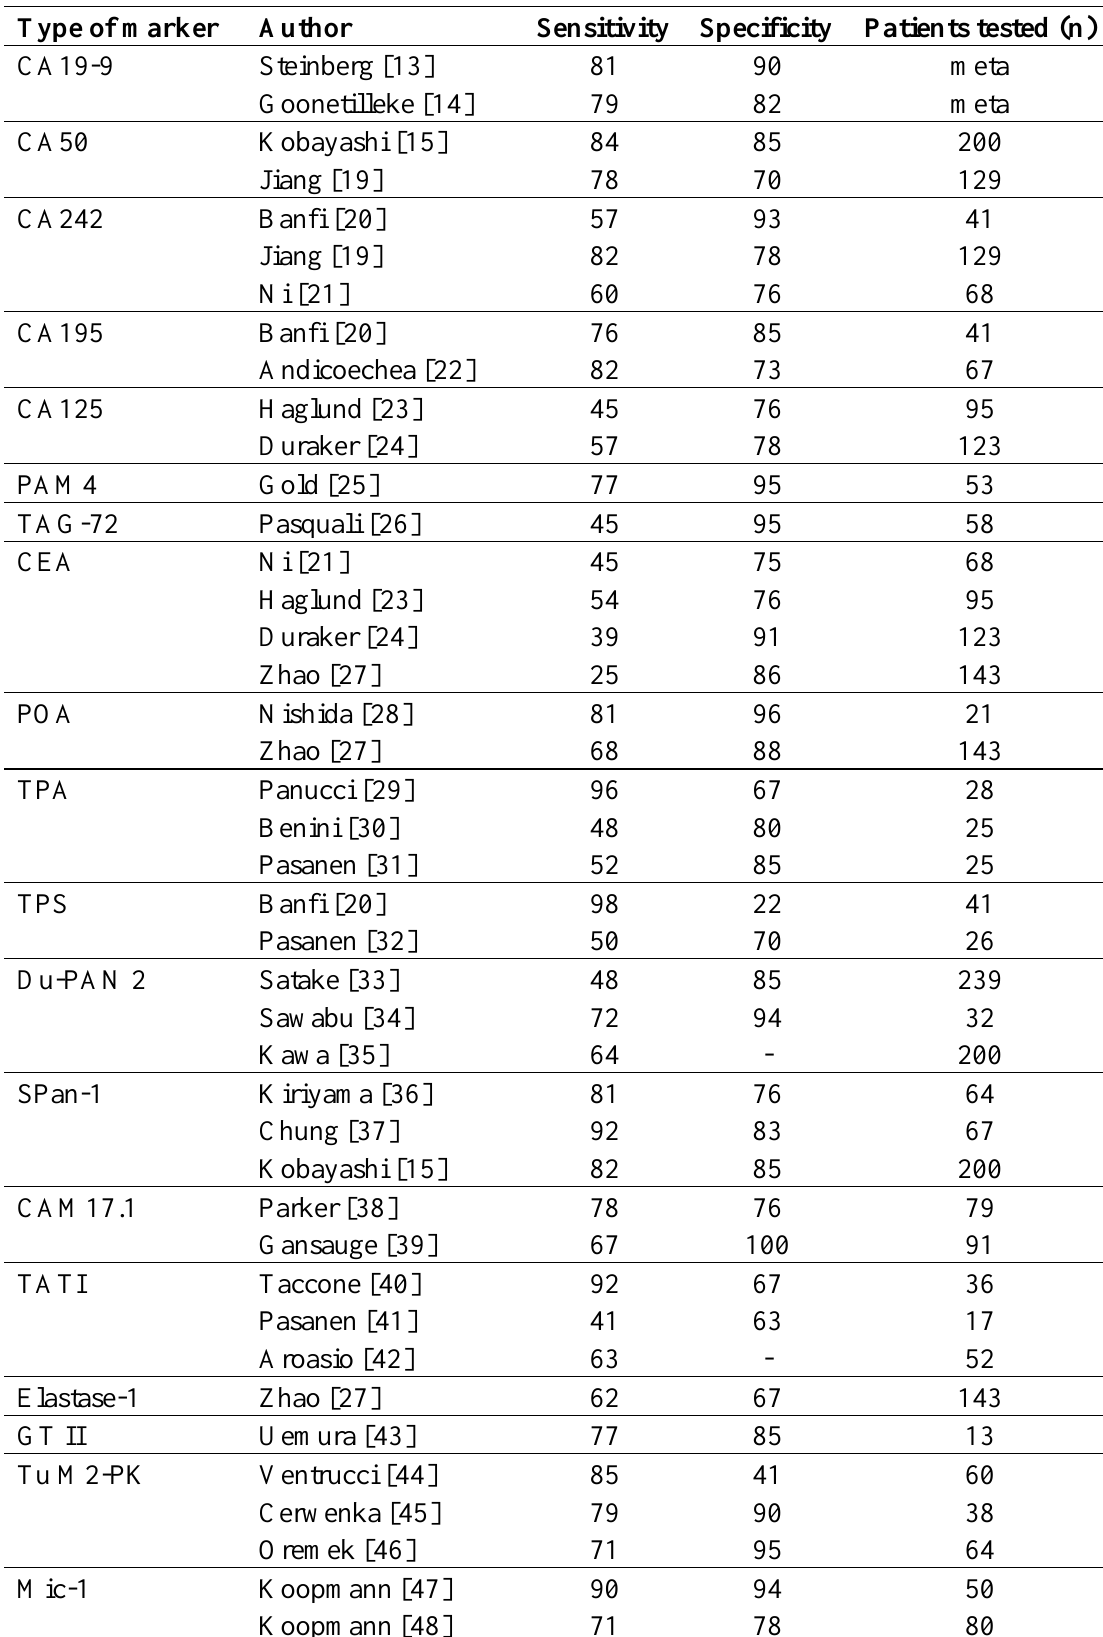
Table 1. Summary of results for diagnostic pancreatic tumor